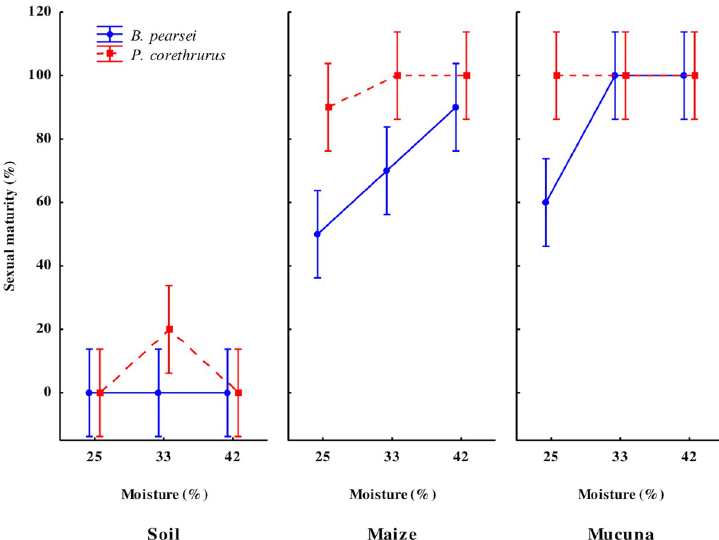
Fig 2. Sexual maturity (formation of the clitellum) in the tropical endogeic earthworms Pontoscolex corethrurus (invasive) and Balanteodrilus pearsei (native) at 100 days of culture under the interaction of three diets of different nutritional quality and three moisture content levels in soil with low anthropic impact. Vertical lines represent standard error.